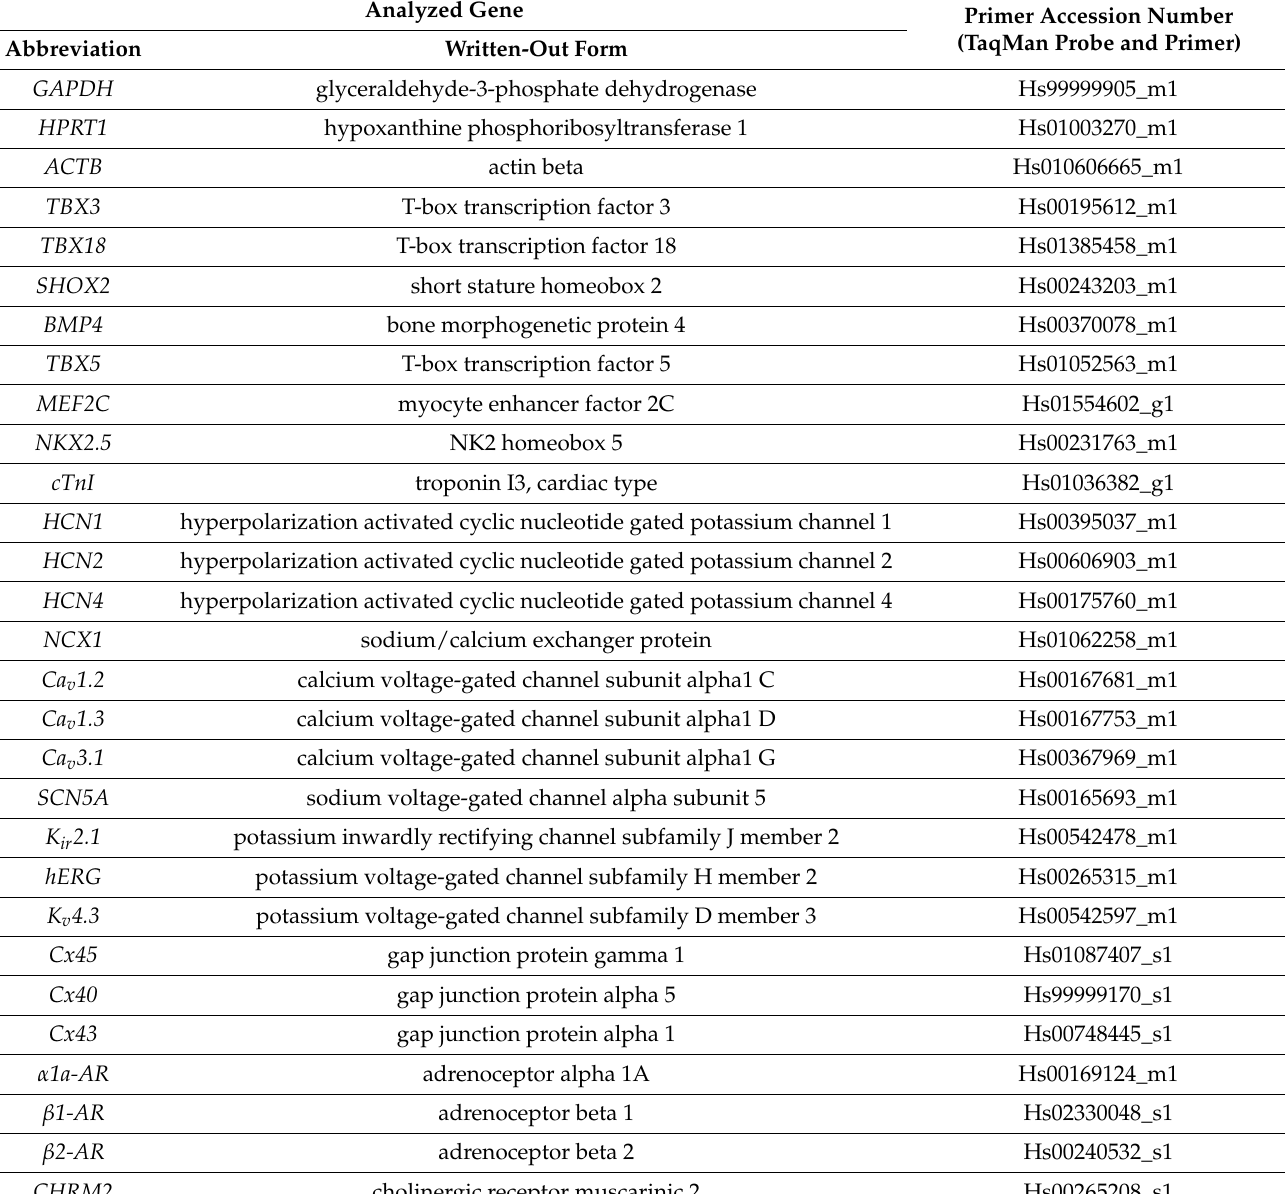
Table 2. Overview of the used TaqMan probes and